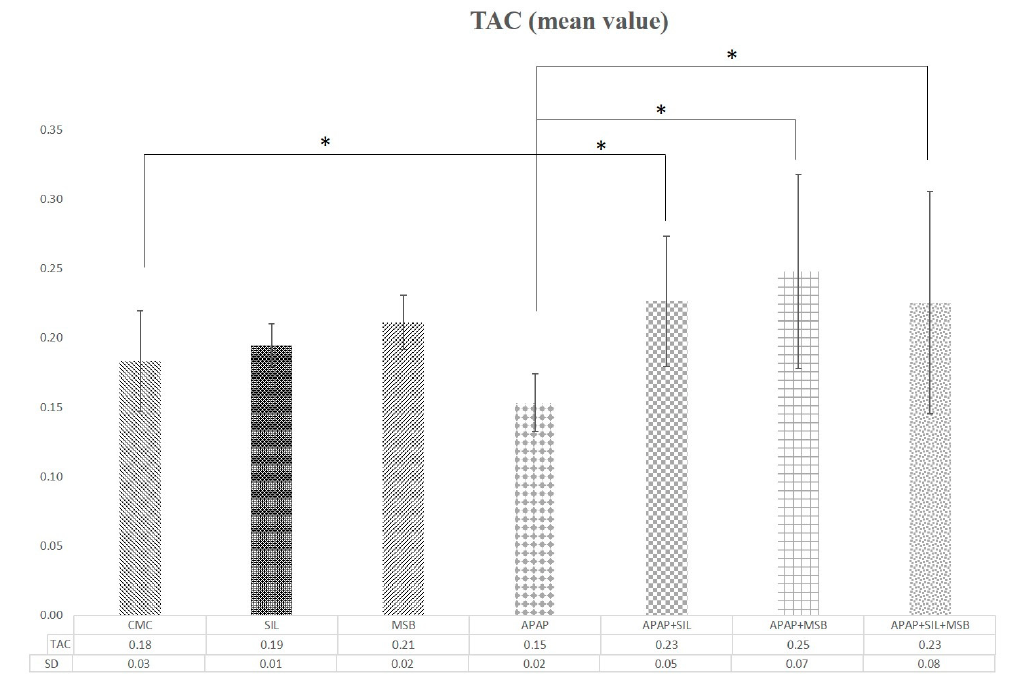
Figure 3. Changes in TAC levels. Rats were treated with 1% CMC, APAP, MSB or SIL either alone or in various combinations (as indicated). Periorbital blood was collected on Day 13, and the serum was tested for TAC levels. * Significant difference ( p <0.05) between groups; data were analyzed using one-